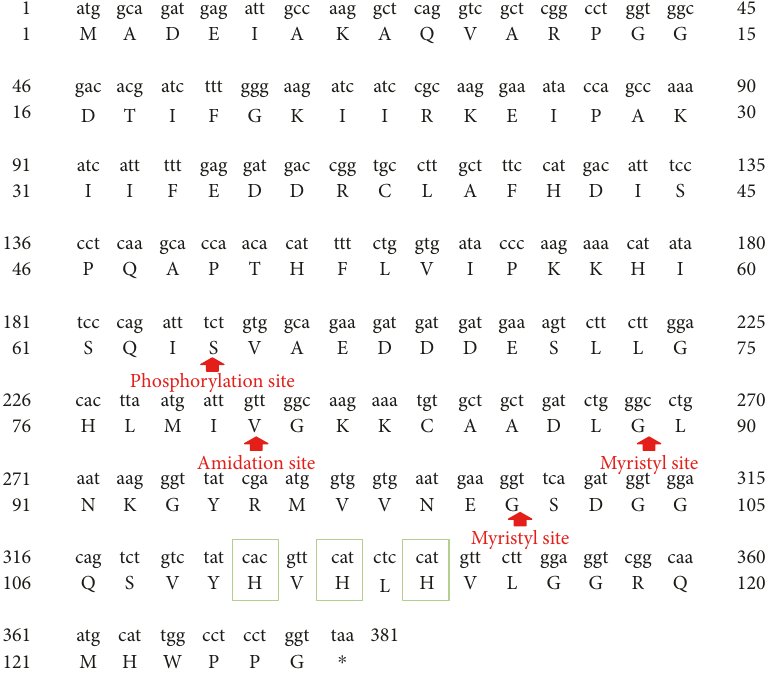
Figure 1: DNA and protein sequences of human HINT1. Green boxes indicate the histidine triad (HIT) domain. The potential modi fi cation sites of the protein are shown, including the phosphorylation site, amidation site, and myristyl site.